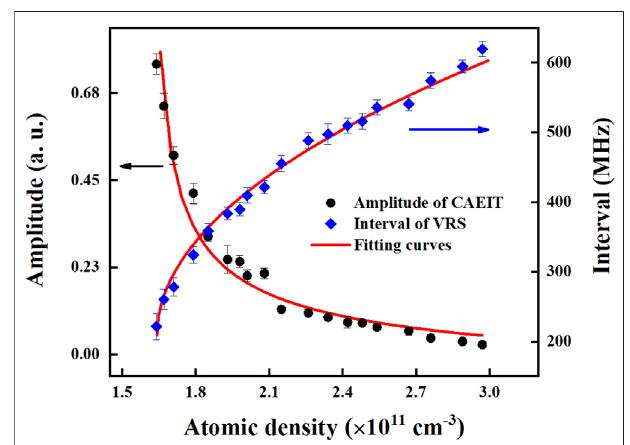
FIGURE 3 | VRS interval and CAEIT amplitude versus atomic density. The blue diamonds represent the interval of VRS, the black dots are the amplitude of CAEIT, and the red lines are the results of theoretical fi